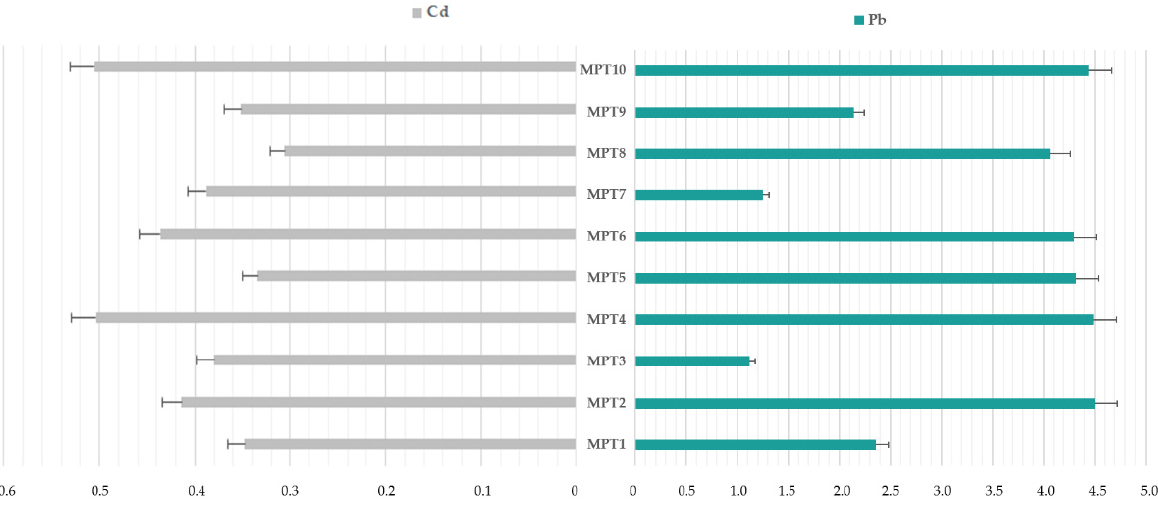
Figure 2. The elemental impurities profile for Cd and Pb in investigated herbal medicinal products with Mentha × piperita L., folium (PTM1–PTM10).